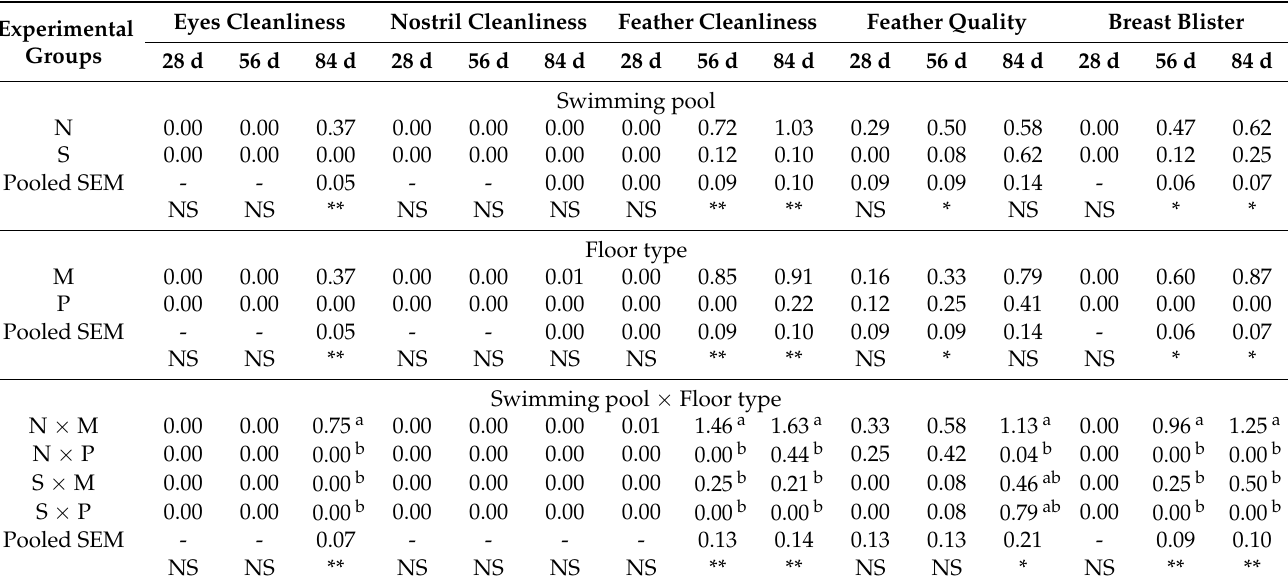
Table 3. Effects of different swimming pool conditions and floor types on the physical condition score of White Roman